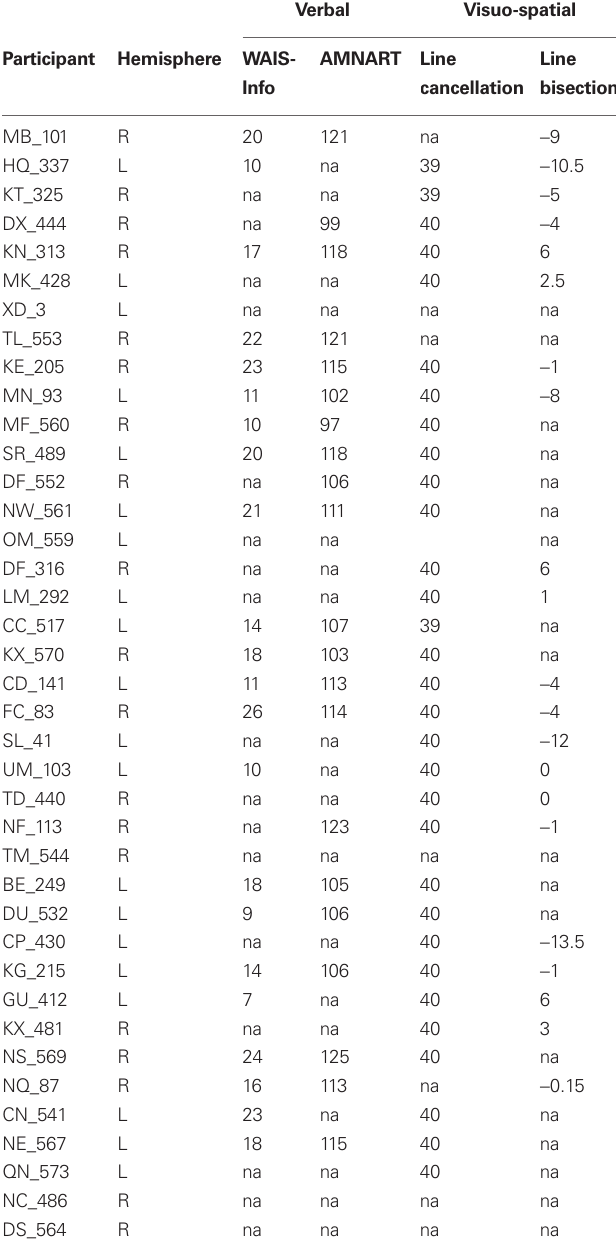
Table 2 | Participant neuropsychological